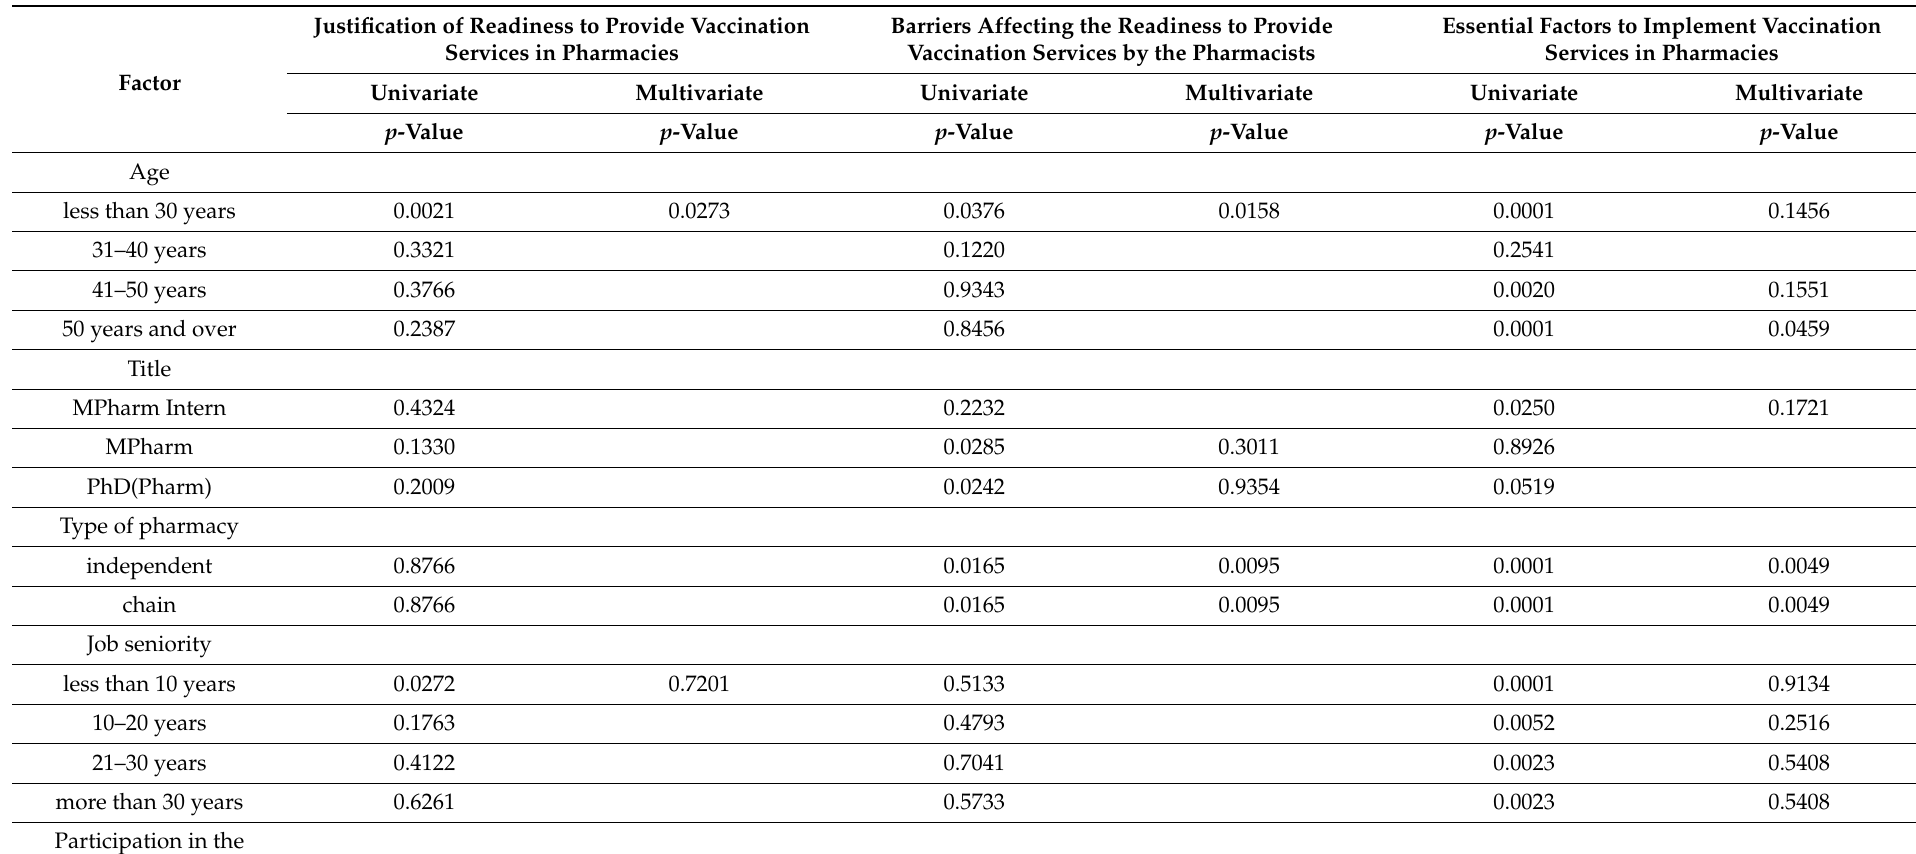
Table 5. Justification of readiness to provide vaccination services, barriers and essential factors to implement vaccination services in pharmacies in relation to basic characteristics of participants—univariate and multivariate regression